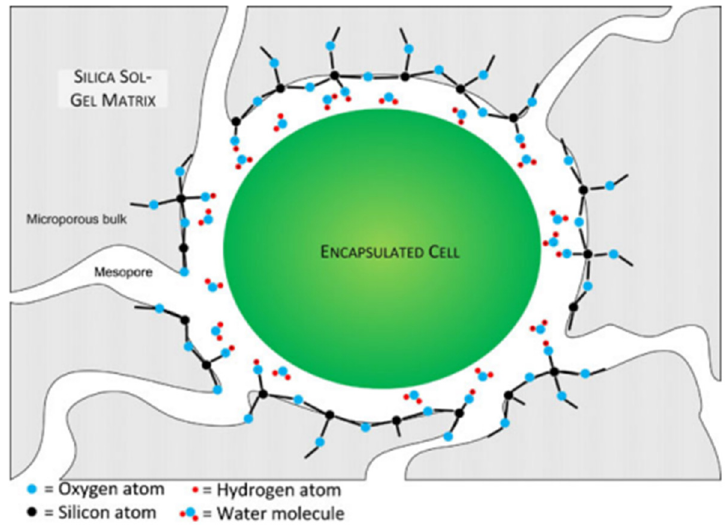
Figure 4. Schematic representation of a cyanobacterial cell encapsulated in silica gel (not to scale). The gel encloses the cell completely within a microporous bulk. The mesopores are large enough to allow diffusion of minerals and nutrients but small enough to contain the encapsulated cell. With alkoxide or aqueous precursors, the surface of the gel is likely composed of hydrophilic condensed silica with some uncondensed hydroxyl functional groups. Reprinted with permission from [26].